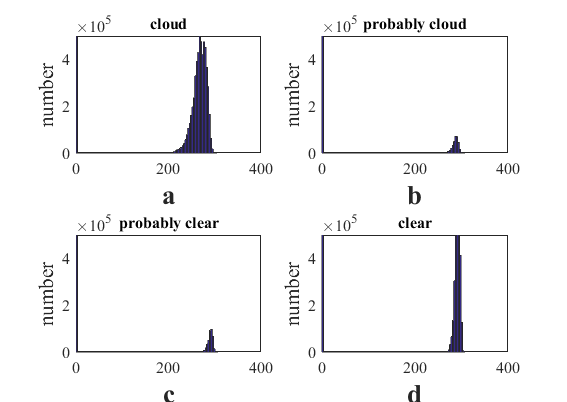
Figure 3. The numerical distribution of BT10.7. Figures a, b, c, and d are the numerical distributions of BT10.7 in the case of “cloud”, “probably cloud”, “probably clear”, and “clear”.